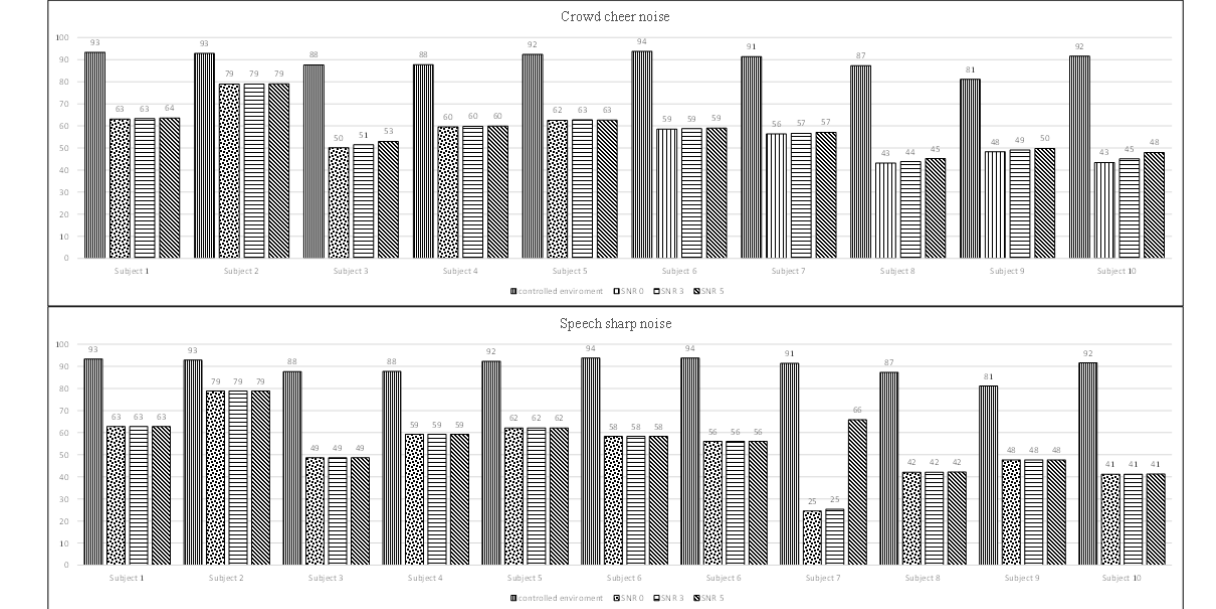
Figure 8. Accuracy of the automatic speech detection system with the presence of 2 different types of background noise (crowd cheer noise and speech sharp noise) at 3 SNR levels. The first bar of each graph indicates the accuracy of the original recording under the controlled environment. SNR: signal-to-noise